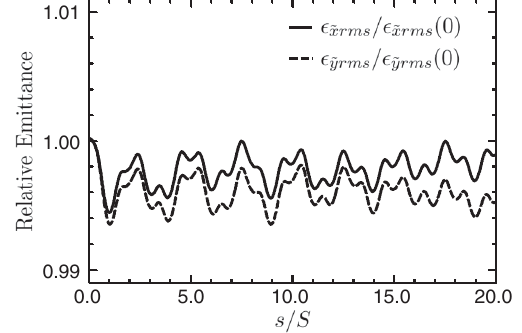
FIG. 4. Plots of the relative rms thermal emittances " tance s=S .